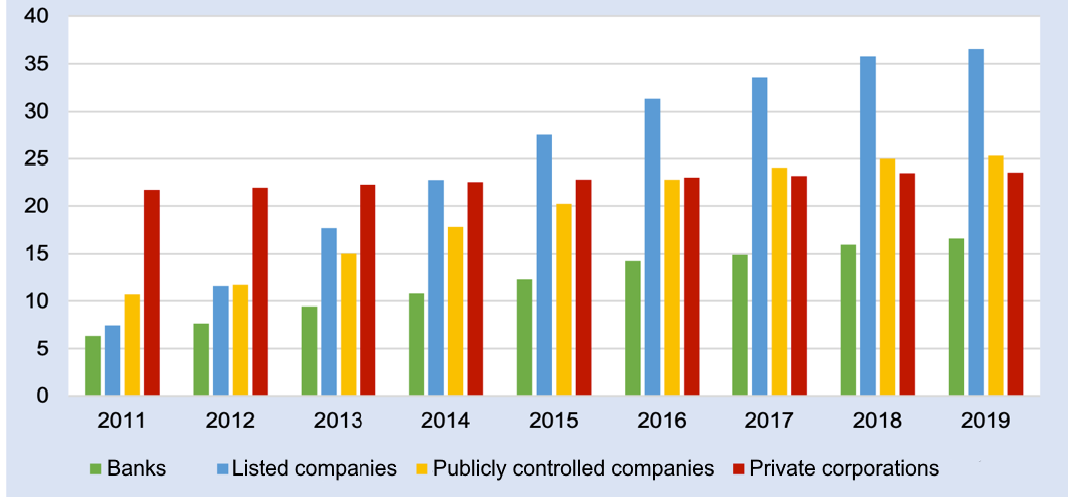
Figure 1. Proportion of Women in the Administrative